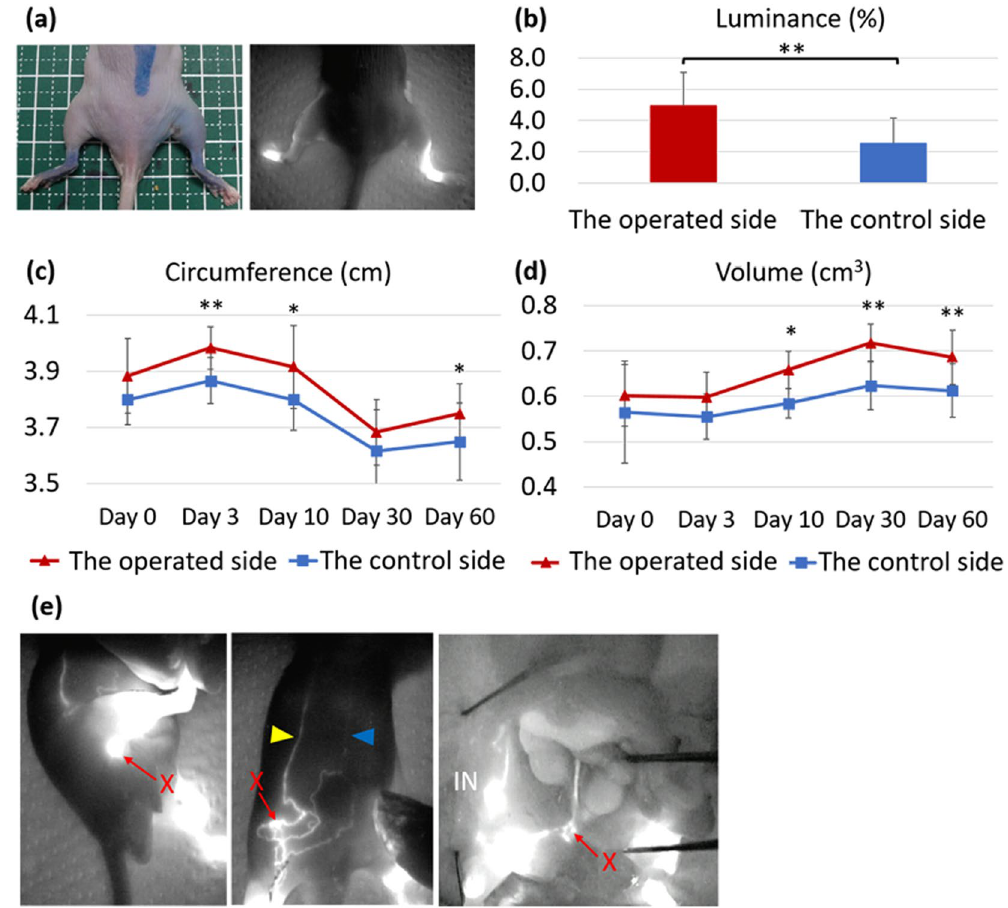
Figure 3. Macroscopic observations after lymphadenectomy. ( a ) Representative images of mice subjected to lymphadenectomy, right hindlimb; the operated side, left hindlimb; the control side. ( b ) The ratio of luminance on day 60. A 2- μ l injection of indocyanine green (ICG) was performed on both hindlimbs on day 58. ( c ) Changes in hindlimb circumference until day 60. ( d ) Changes in hindlimb volume until day 60. ( e ) Representative images of lymphography obtained from operated areas on day 60 after lymphadenectomy. Left image; operated areas from which popliteal lymph nodes (LNs) were excised after a 2- to 10- μ l injection of ICG at both food pads, center image; operated areas from which inguinal LNs were excised after a 2- to 10- μ l injection of ICG at both ankles, right image; operated area from which iliac LNs were excised after a 2- to 10- μ l injection of ICG at both food pads. In some mice, lymph flow connected two lymphatics in the abdomen (yellow and blue arrowheads) after passing the hindlimb. Red crosses; operated area, IN; inguinal LN. N = 6 in b, c, d and e. * P < 0.05 and ** P < 0.01 versus the control (paired t